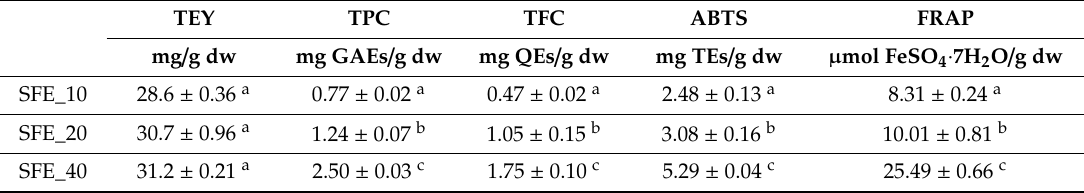
Values are means of three replications ± standard deviation. Values in the same column followed by di ff erent superscript letters di ff er significantly ( p < 0.05). SFE: supercritical fluid extraction. GAEs: gallic acid